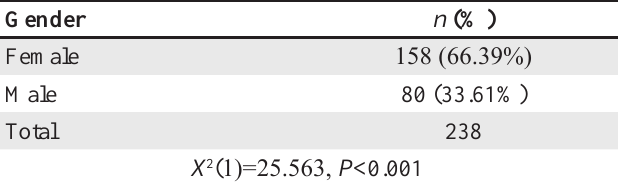
Table 2 : Sex distribution of patiens having globus in study group